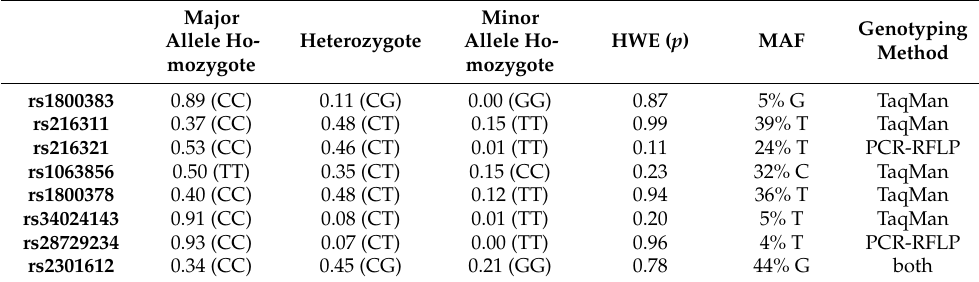
Table 4. Genotype distribution of analyzed SNPs across all cohorts. MAF: minor allele frequency. Levels of statistical significance for Hardy–Weinberg equilibrium (HWE) were calculated using the χ 2